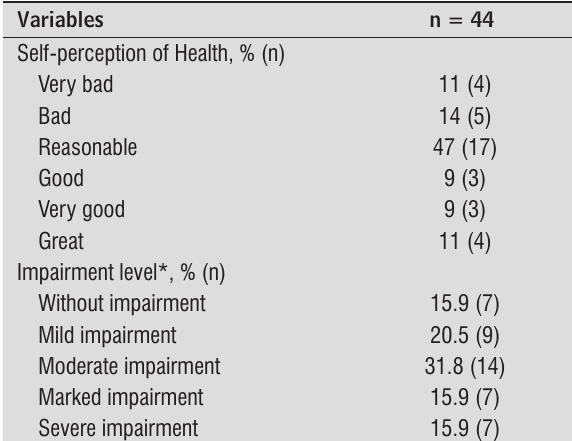
Table 1 - Clinical and demographic variables